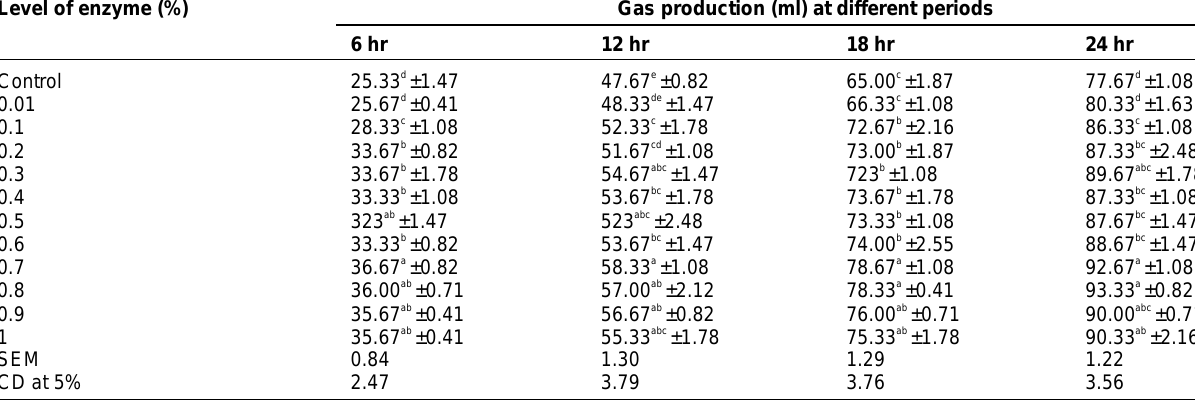
Table-1. Effect of neutral cellulase on in vitro gas production (ml) from dry jowar Level of enzyme